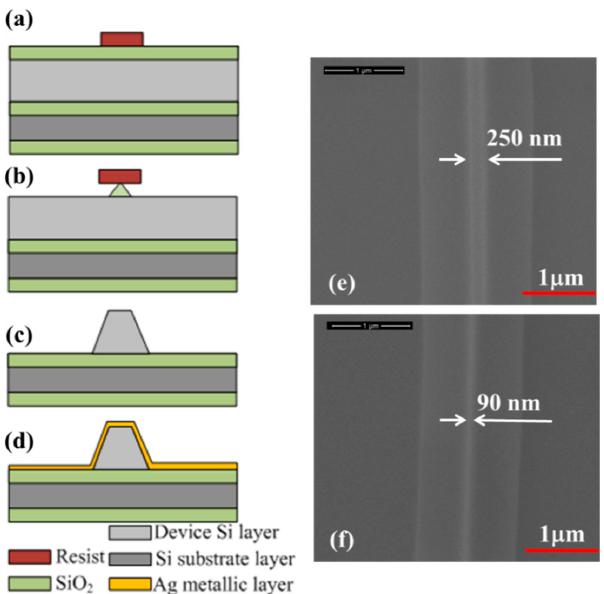
Figure 2. ( a – d ) Schematic of the fabrication flow of the wedge SPP waveguides; ( e – f ) FESEM images of the trapezoidal-shaped silicon waveguides fabricated on the (100) SOI wafer by using a KOH etching solution.